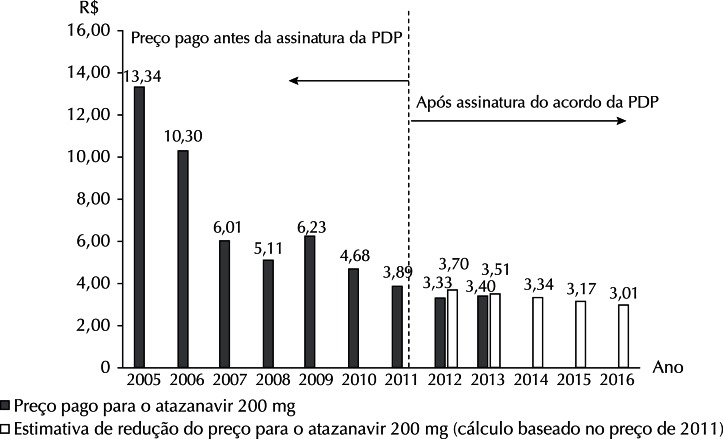
Preços pagos pelo atazanavir 200 mg e estimativa de redução após assinatura do acordo da Parceria para Desenvolvimento Produtivo. Brasil, 2005 a 2016.